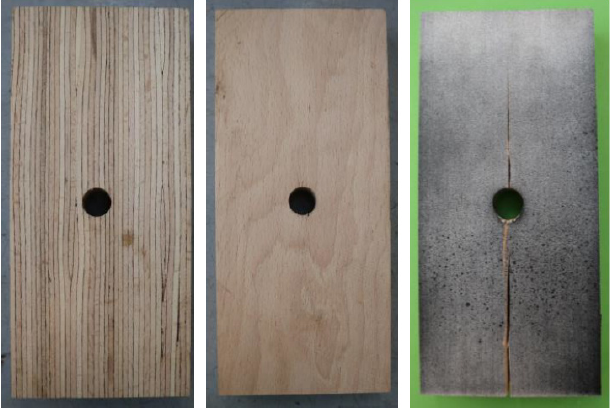
Figure 9. Beech LVL specimens for embedment tests with edgewise-arranged veneers ( left ), with flatwise-arranged veneers ( centre ) and with stochastic pattern after testing ( right ) [34].